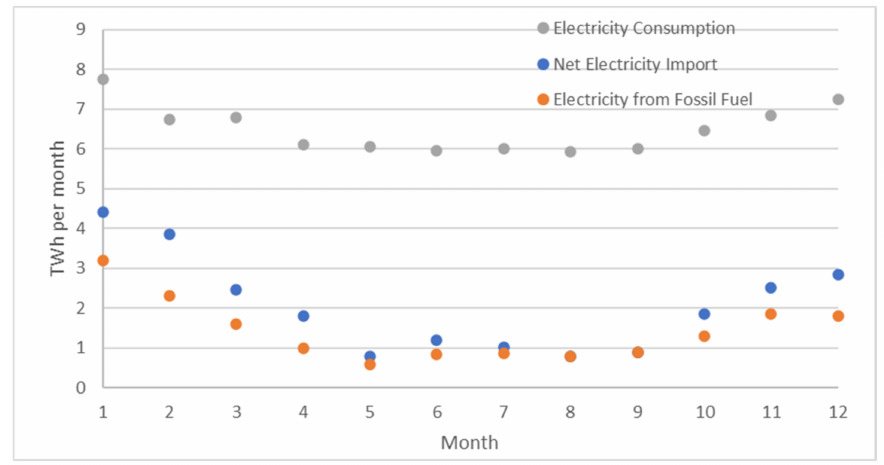
Figure 9. Electricity consumption over the course of a year in Austria in 2017 (modified after [72] with permission from Österreichischer Biomasse-Verband 2019).